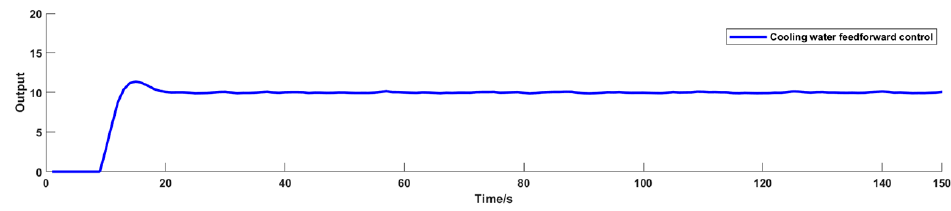
Figure 8. Feedforward control e ff ect.